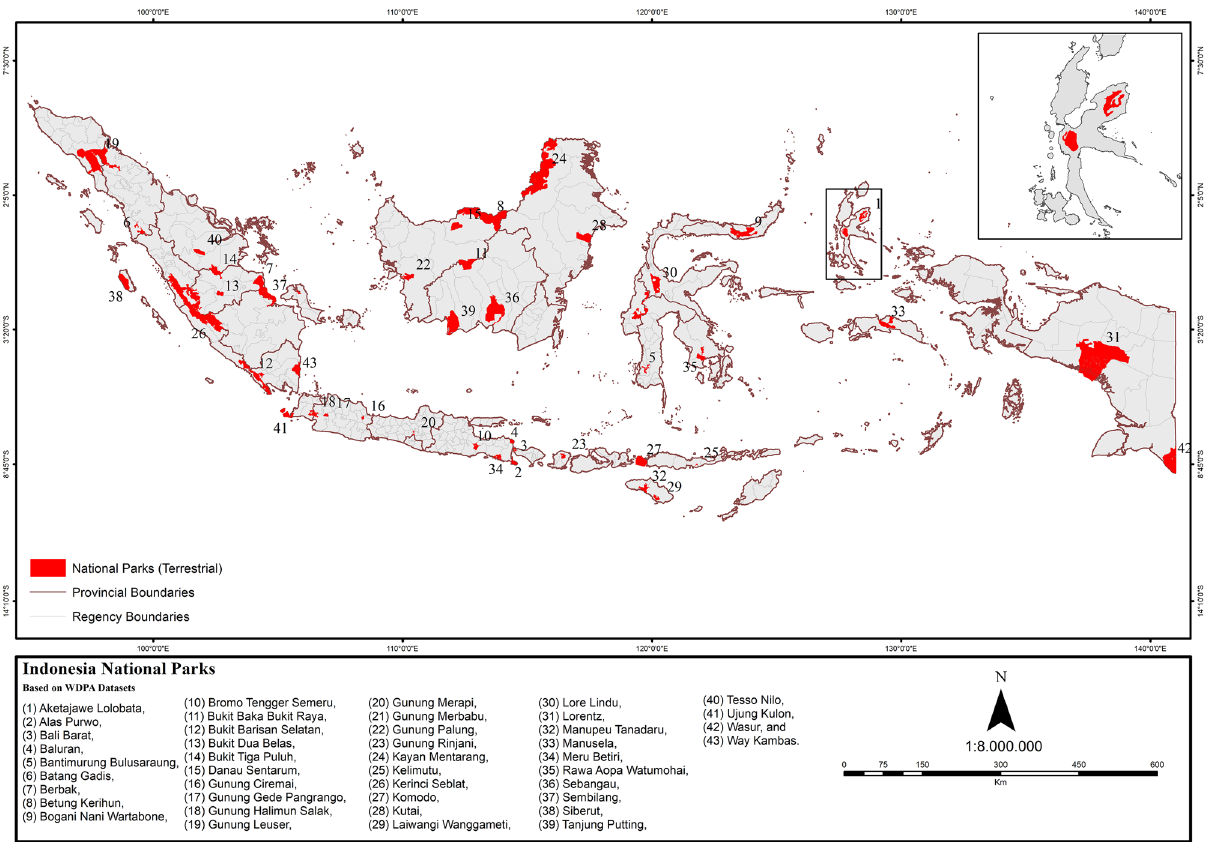
Figure 6. Forty three (43) terrestrial national parks in Indonesia included in the analysis. National parks boundaries were obtained from The World Database on Protected Areas (https ://www.prote ctedp lanet .net/en). The Map was created using Esri ArcMap 10.8 (https ://www.arcgi